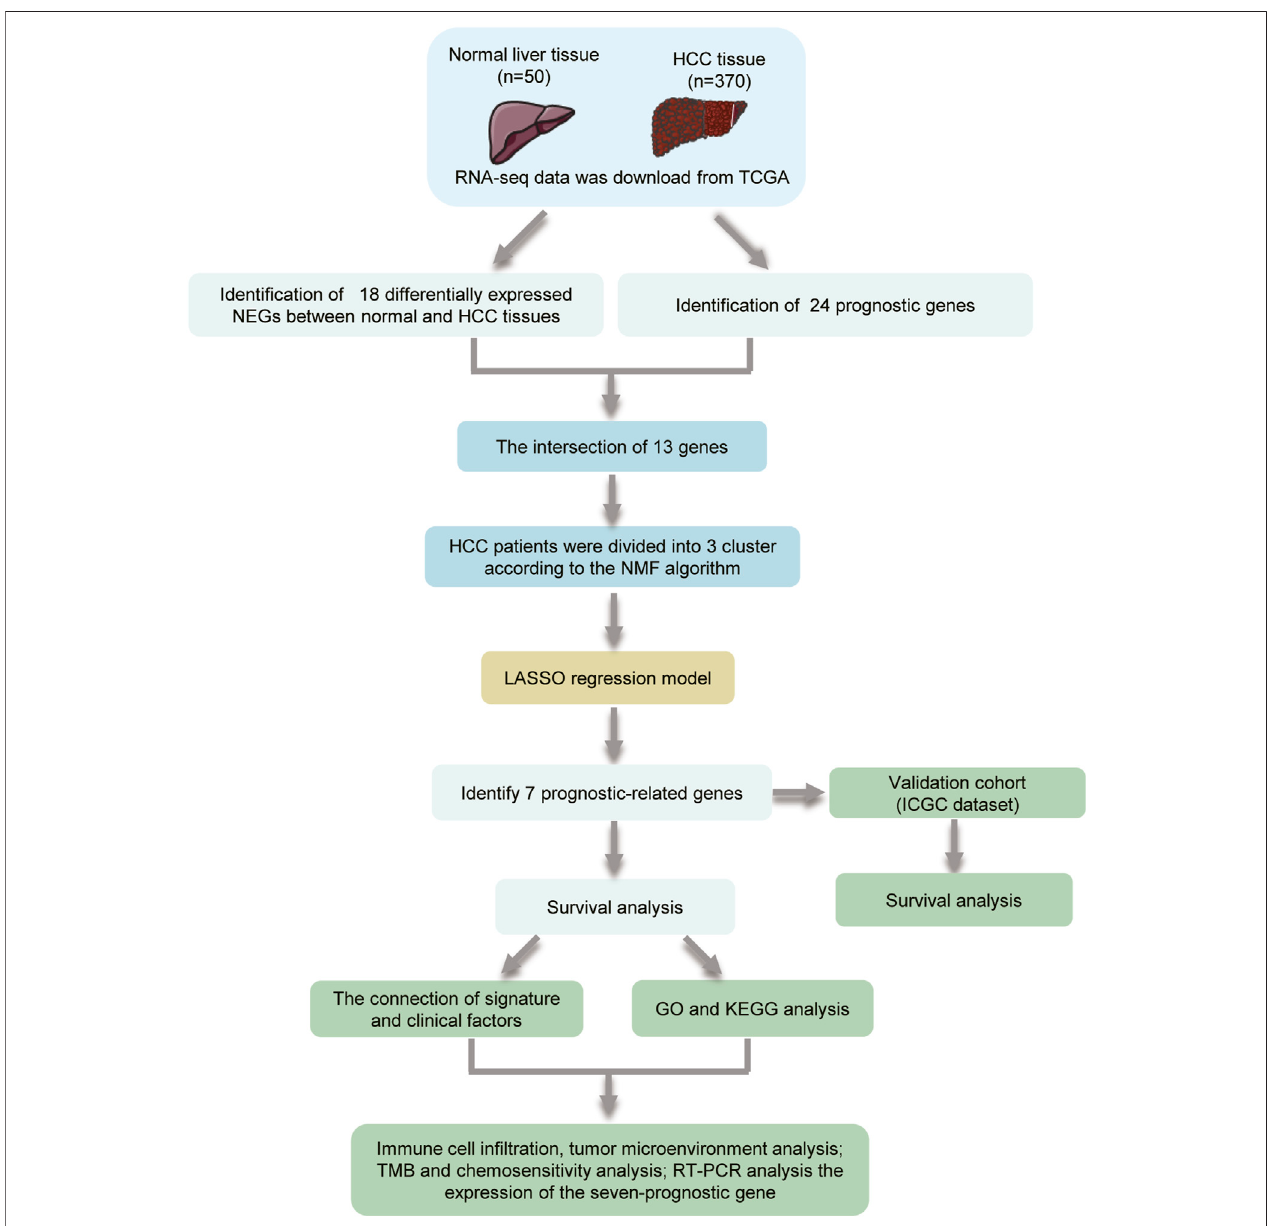
FIGURE 1 | Flowchart showing the scheme of the